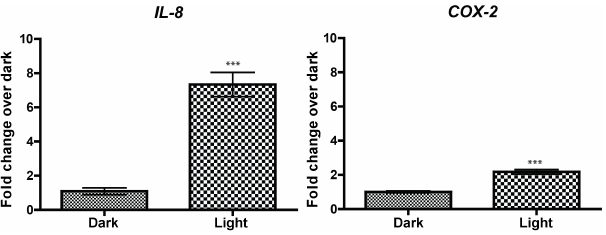
Figure 4. IL-8 and COX-2 mRNA expression induced by expo- sure to isoprene-derived SOA using EAVES device all normalized to dark control experiments and against the housekeeping gene, β - actin. All experiments conducted in triplicate. ∗∗∗ p < 0.0005.